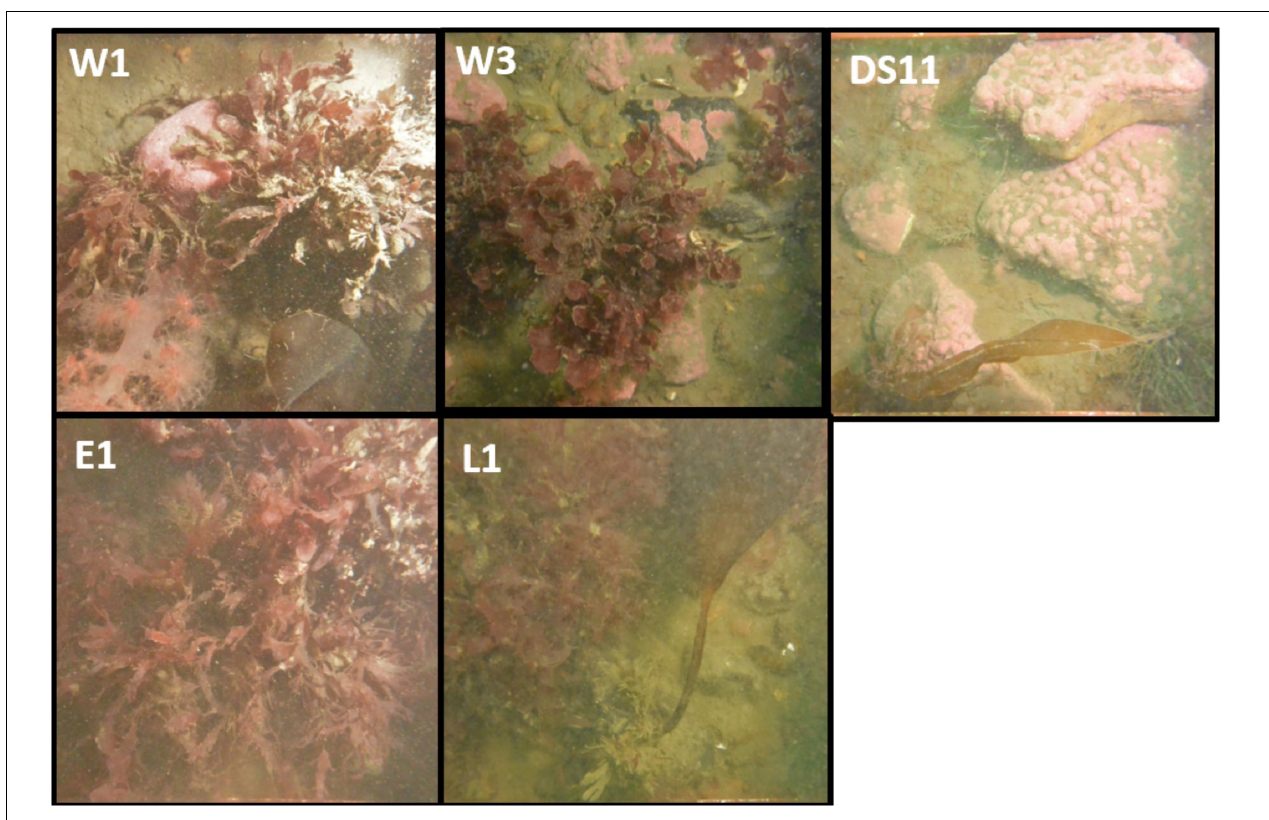
FIGURE 3 | Example photoquadrats from each site. TABLE 3 | Mean percent cover ( ± SD ) of each functional group in the established benthic community at each site. Foliose red algae Kelp